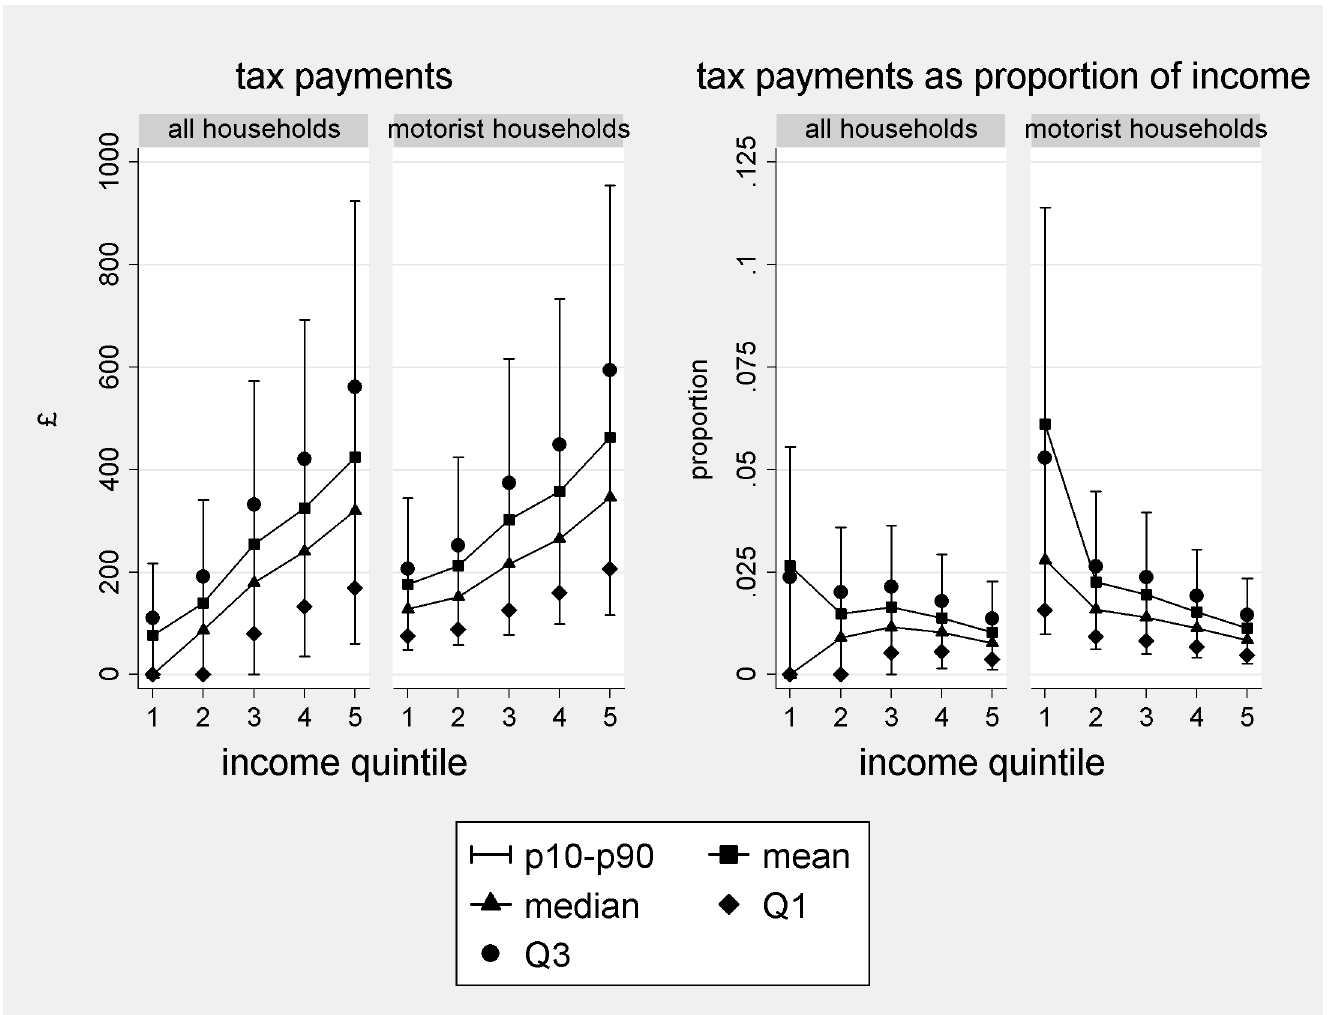
Fig 8. Estimated monetary effectsof a carbon tax or ration at £100/tCO 2 . Note: ‘diary sample’weights applied,recalculatedfor the pooledsample.